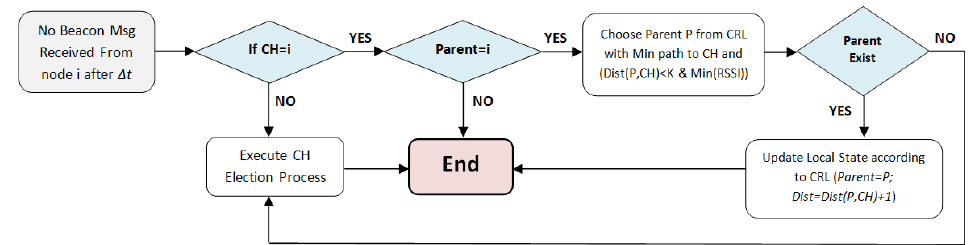
Figure 7. The cluster head leaving